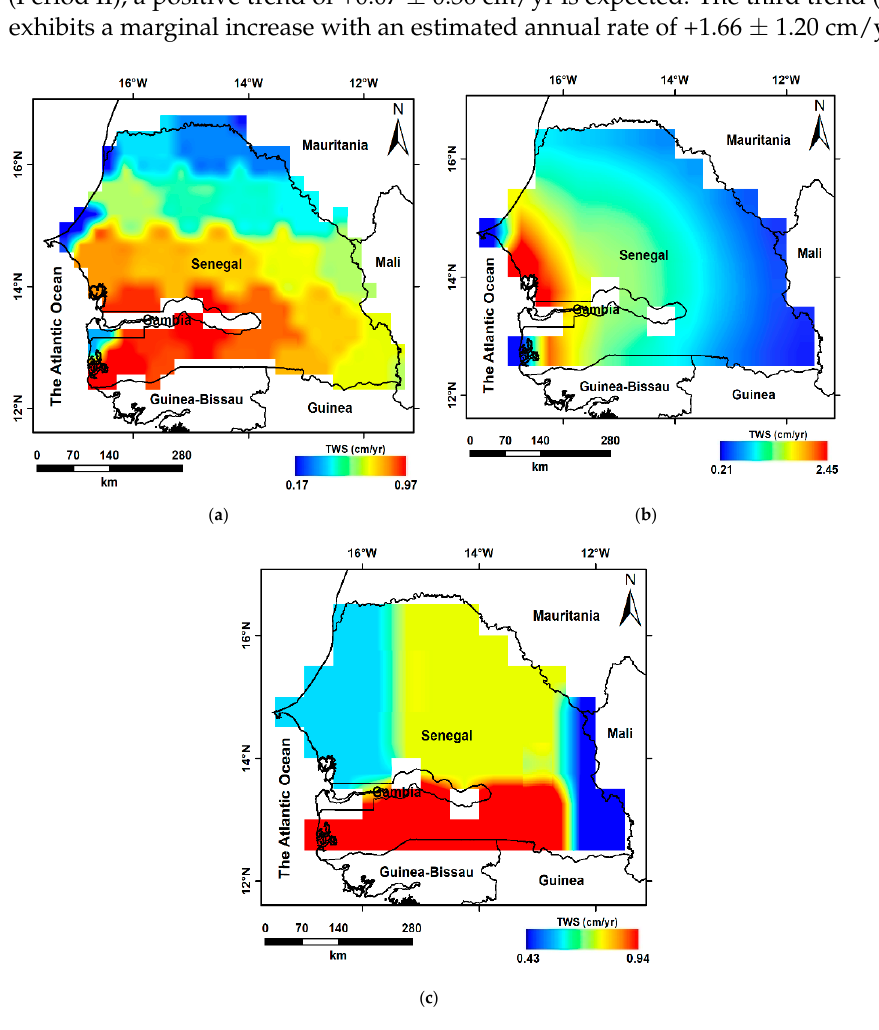
Figure 3. A color-coded secular extracted Δ TWS trend map for Senegal was derived by averaging the monthly CSR ( a ), GSFC ( b ), and JPL ( c ) products over the country.